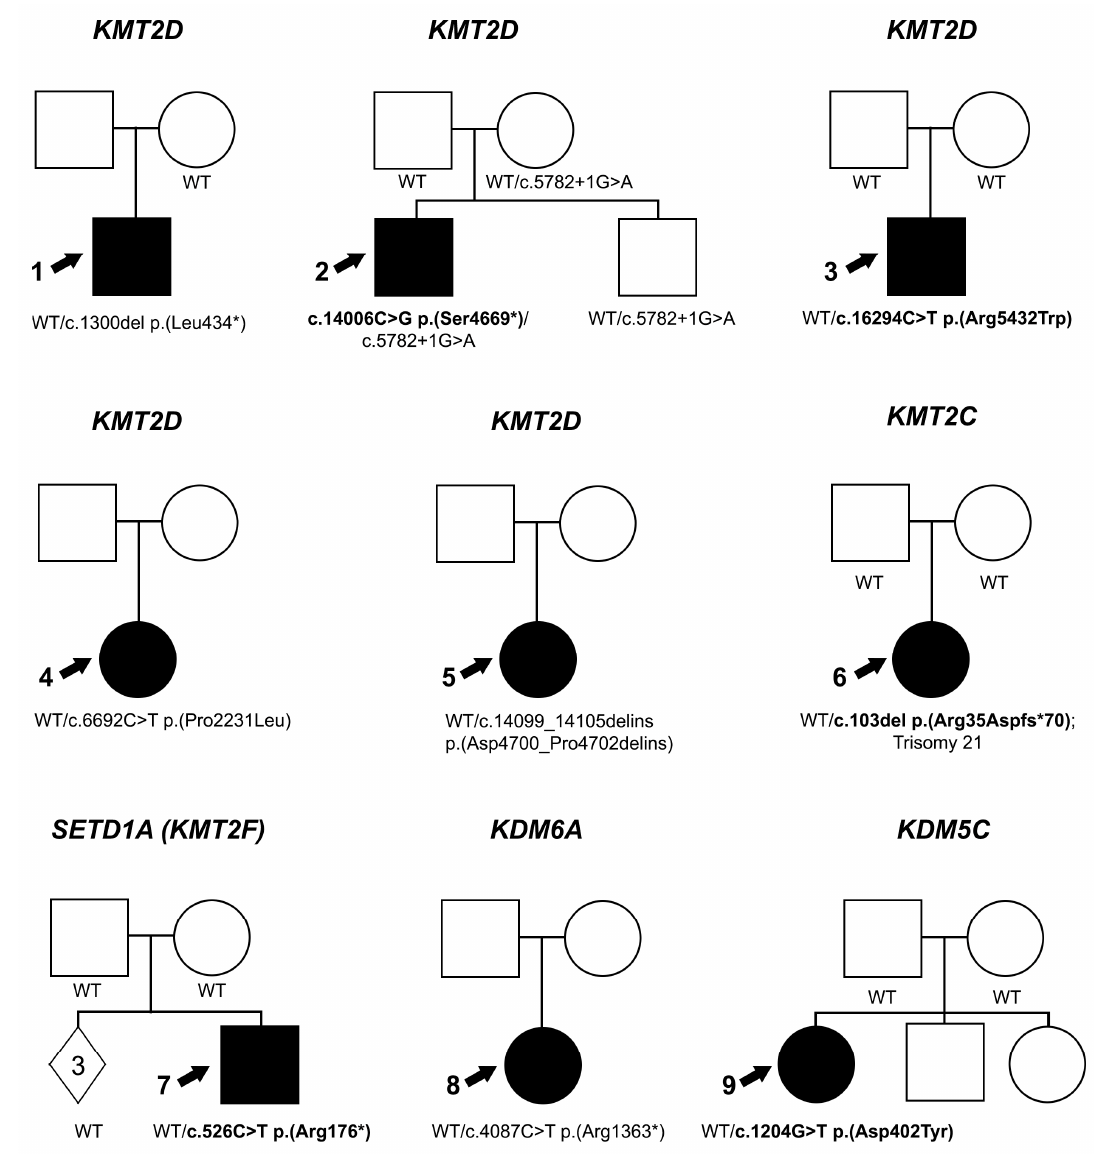
Figure 2. Pedigree information. Pedigrees for Individuals 1–9 (indicated with an arrow). Genetic data are indicated for each individual in the family who was tested. De novo variants are indicated in bold; WT indicates wild type sequence at variant location and solid symbol indicates affected individuals.